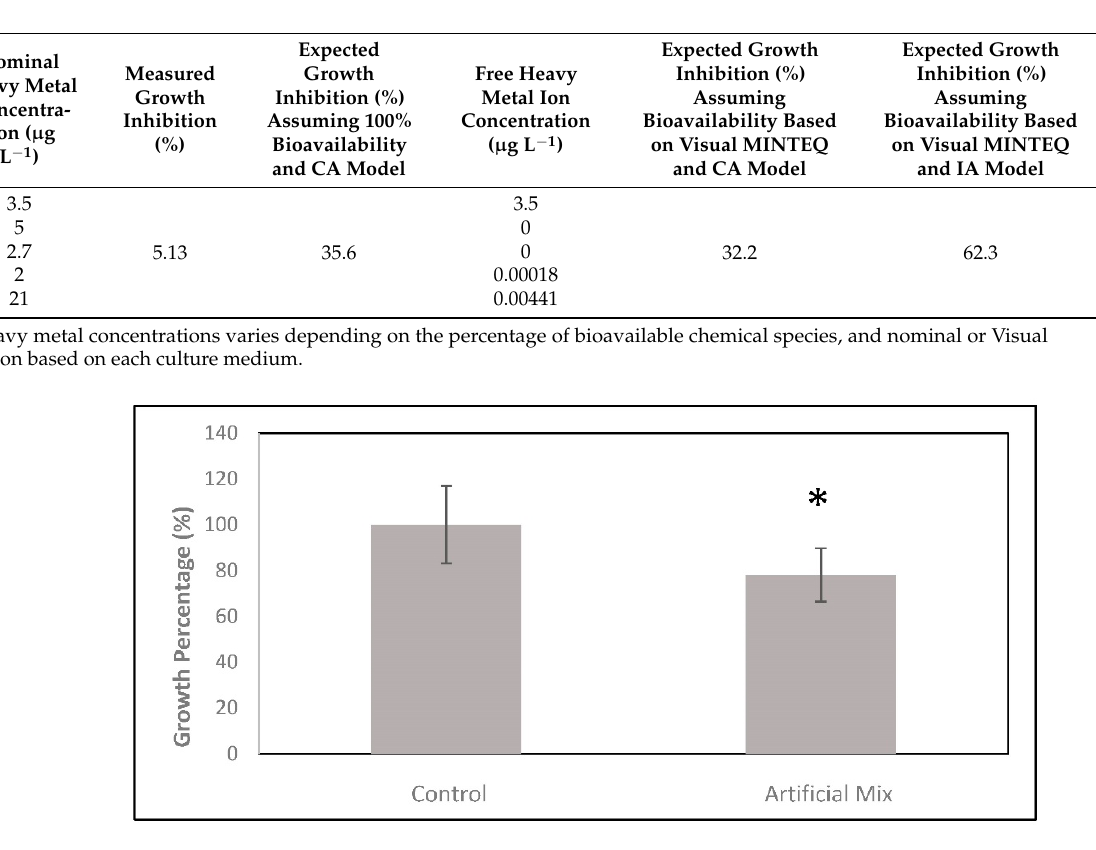
Figure 2. Growth of C. vulgaris exposed to artificial mixture of heavy metals (Artificial Mix.) (*) No significant difference to control. Table 4. Selected expected effective concentrations (ECx) for 48 h exposure to heavy metals mixture for growth inhibition calculated with concentration-response curves using concentration addition (CA) and independent action (IA) models.